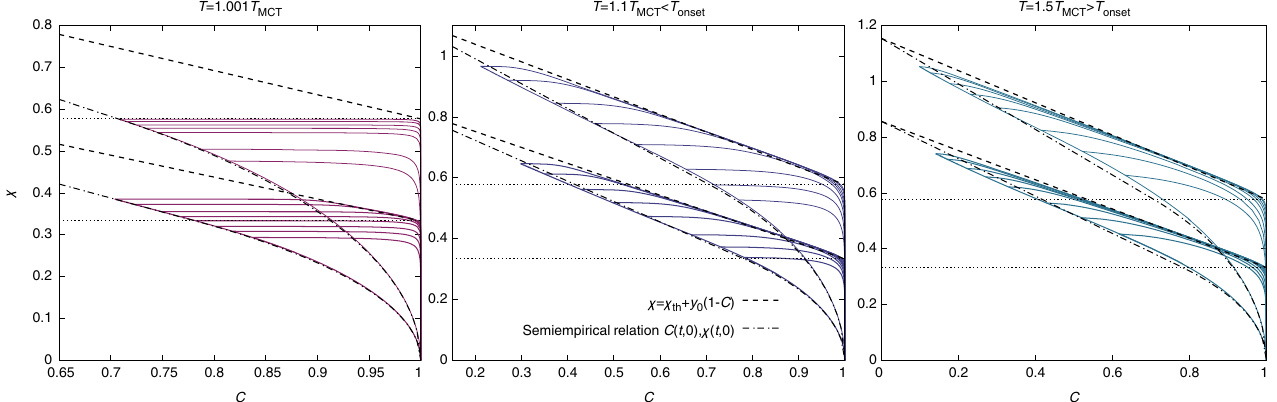
FIG. 12. FD curves χ ð t; s Þ versus C ð t; s Þ , each one with a different largest time t , plotted parametrically by varying the smallest time s . In each panel, upper data are for the pure three-spin model, while lower data are for the mixed ( 3 þ 4 )-spin model. Notice that the three panels have different scales, but the dashed and dash-dotted lines are the same in all panels (see text for details).